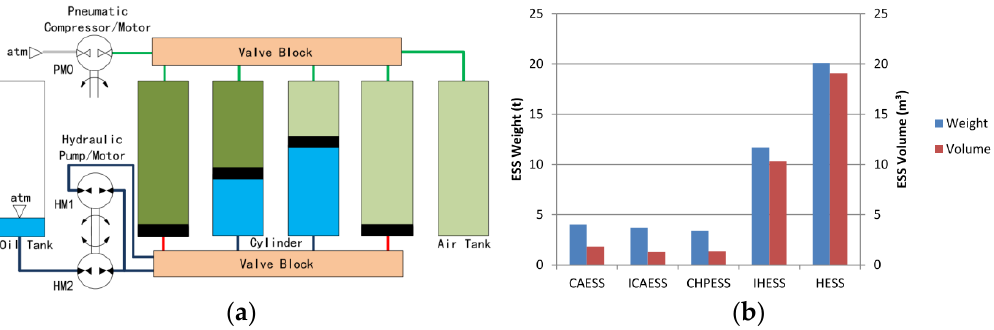
Figure 18. Proposed novel coupled hydro ‐ pneumatic hybrid system [112]: ( a ) coupled layout; ( b ) volume and weight of HMT.